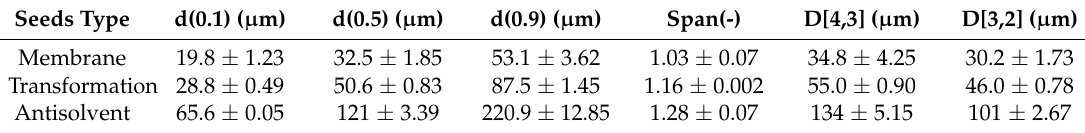
Table 1. Malvern Mastersizer data for the seeds used, where d(0.1), d(0.5), and d(0.9) are the particle diameters at 10%, 50% and 90% of the cumulative distribution, span was calculated as [d(0.9) − d(0.1)]/d(0.5), and D[4,3] and D[3,2] are the volume and surface weighted mean diameters, respectively. The table shows the average values of all the measurement replicates and corresponding standard deviations.